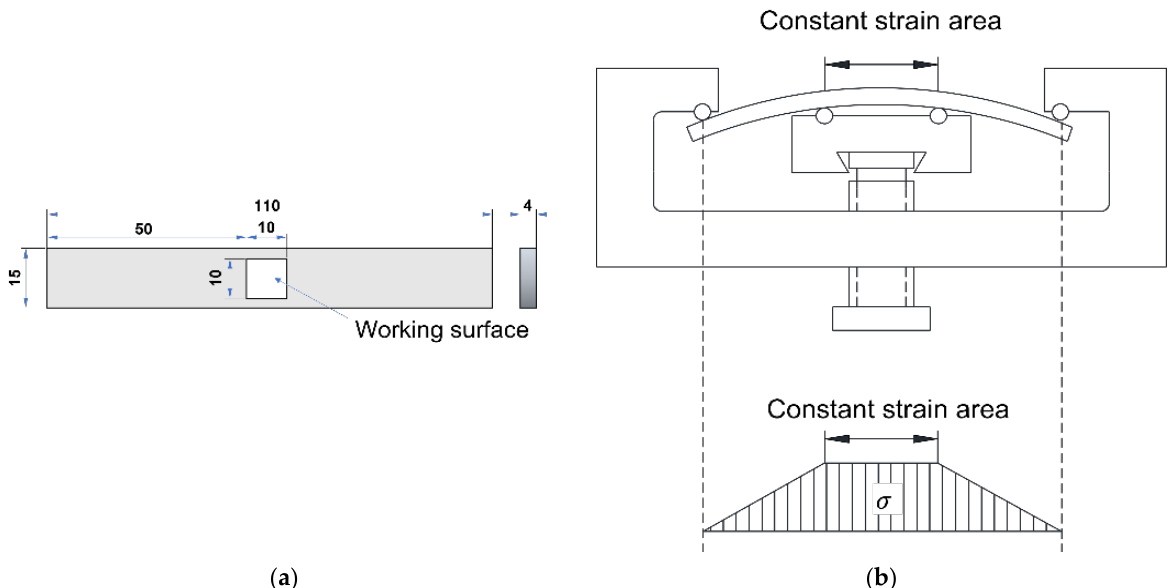
Figure 1. Tensile stress–strain curve of the X80 steel.